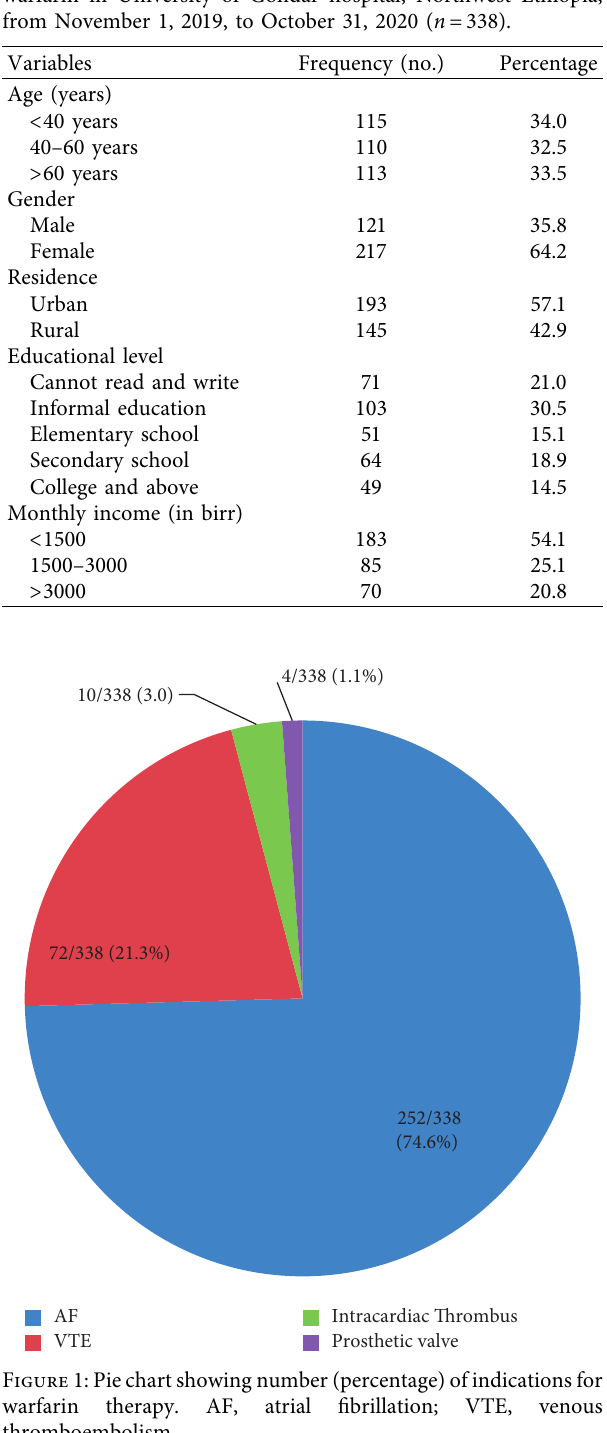
Table 1: Sociodemographic characteristics of patients taking